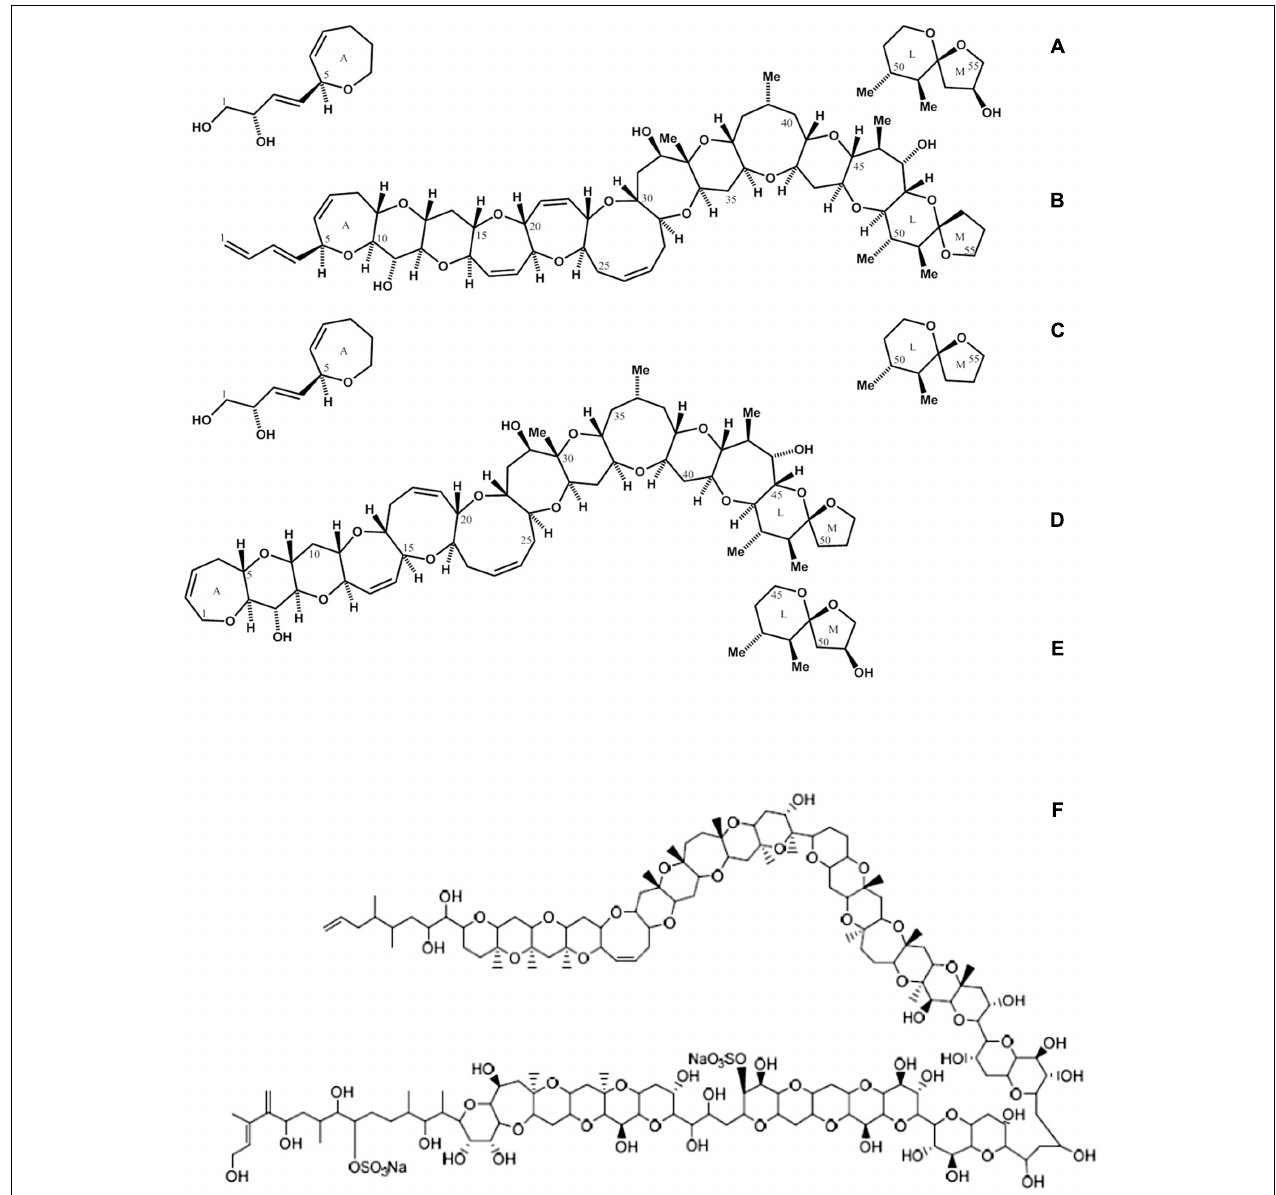
FIGURE 2 | Some toxins associated with ciguatera fish poisoning (CPF) and originating from members of the genus Gambierdiscus and/or Fukuyoa : (A) CTX1B; (B) CTX4A; (C) epideoxyCTX1B; (D) CTX3C; (E) 51OH-CTX3C; (F) MTX. Structures modified from Ajani et al. (2017) and Kato and Yasumoto